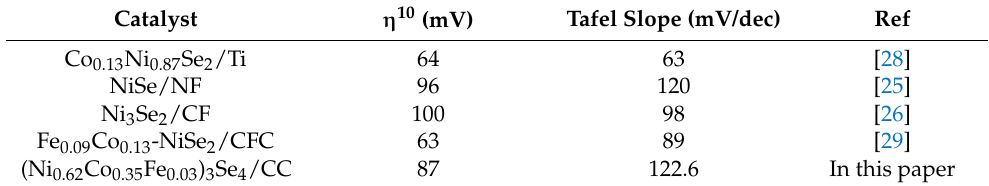
Figure 6. ( a ) HER LSV curves of (Ni 0.62 Co 0.35 Fe 0.03 ) 3 Se 4 /CC, Ni 3 Se 4 /CC in 0.5 M H 2 SO 4 ; ( b ) corre- sponding Tafel plots. Table 1. Benchmarking the Metal (Fe, Co, Ni) Selenides with Respect to the HER overpotential at 10 mA/cm 2 ( η 10) in 1 M